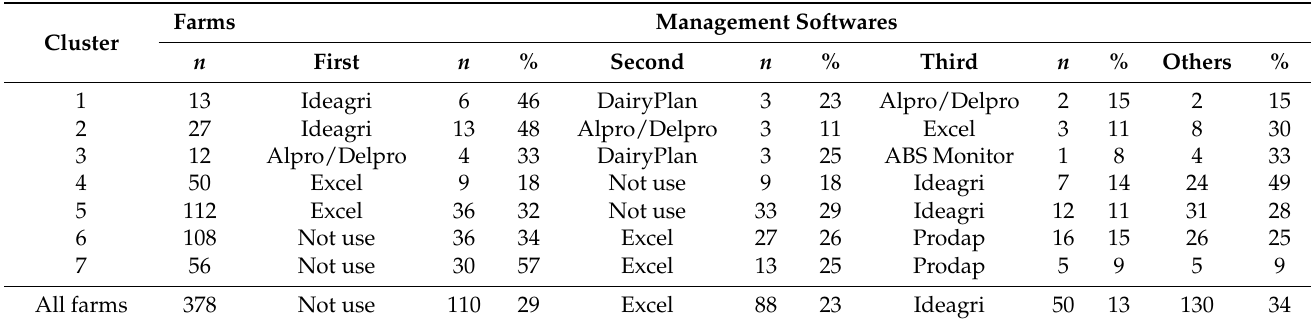
Table 5. Top three herd management software used by farmers.